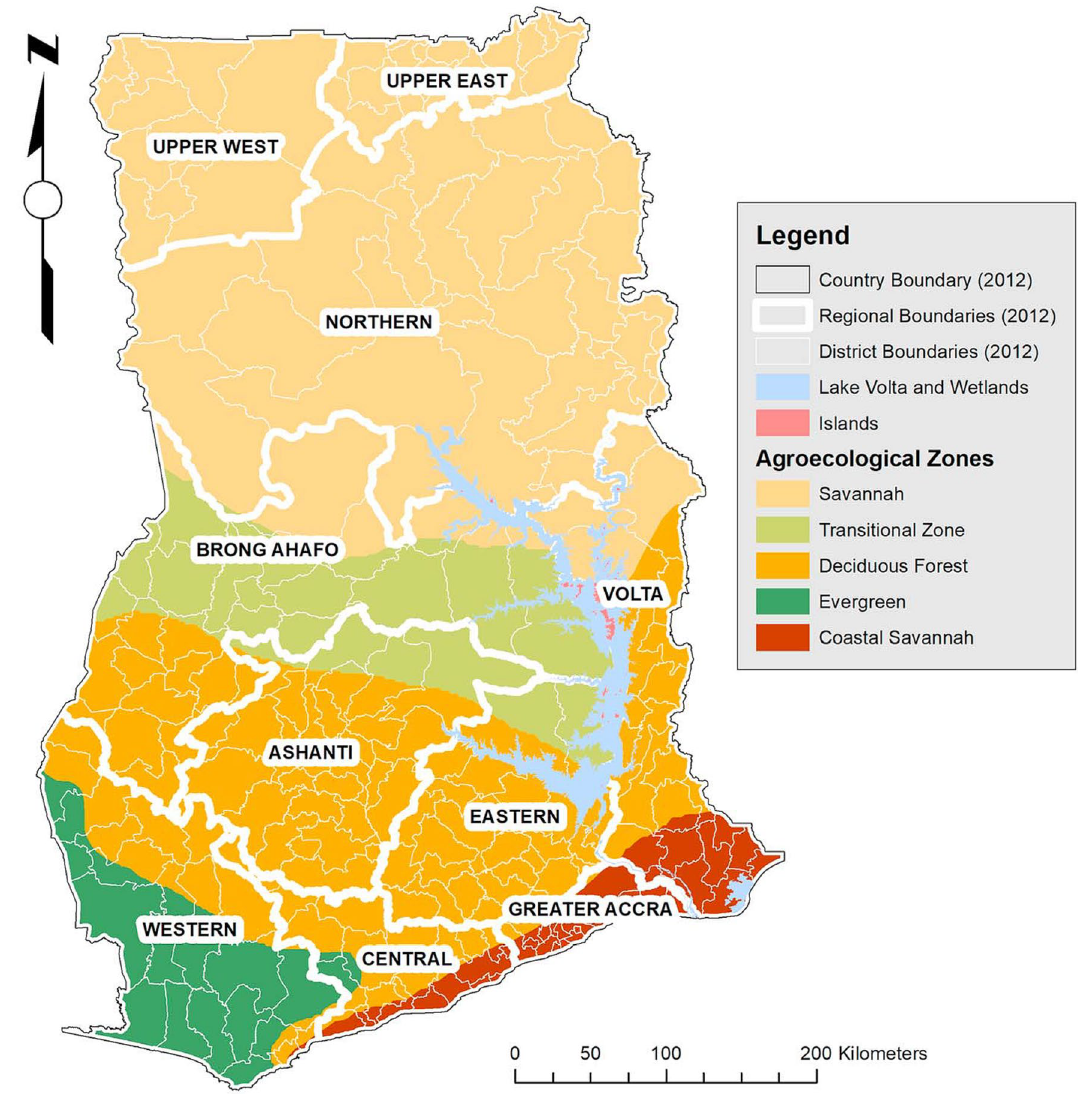
Figure 1. Map of Ghana showing regions of sampling (Adapted from Abbam et al. 33 ).